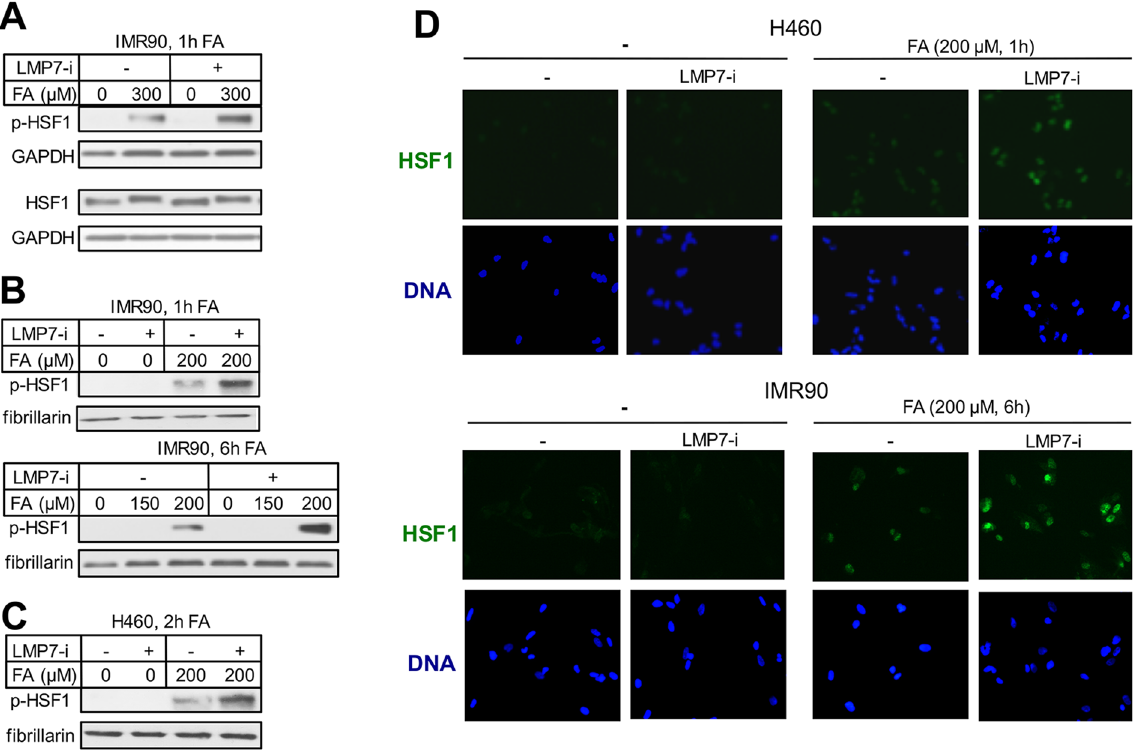
Figure 6. HSF1 activation in cells with inhibited i-proteasomes. Cells were treated with FA in the absence or presence of 0.3 μ M LMP7-i. ( A ) Westerns for HSF1 and its S326-phosphorylated form (p-HSF1) in whole cell lysates of IMR90 treated with FA for 1 h. ( B ) S326-phosphorylated HSF1 in the nuclear fraction of IMR90 cells. ( C ) Nuclei-bound phospho-S326-HSF1 in H460 cells treated with FA for 2 h. ( D ) Nuclear HSF1 in FA-treated H460 and IMR90 cells. Cells were extracted with 0.2% Triton X-100 in PBS for 10 min at 4 °C before HSF1 activation.